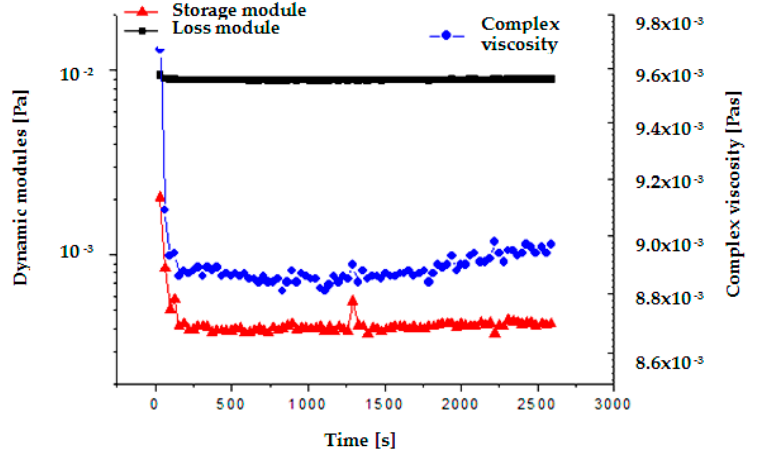
Figure 16. Storage module, loss module and complex viscosity for butyl stearate.